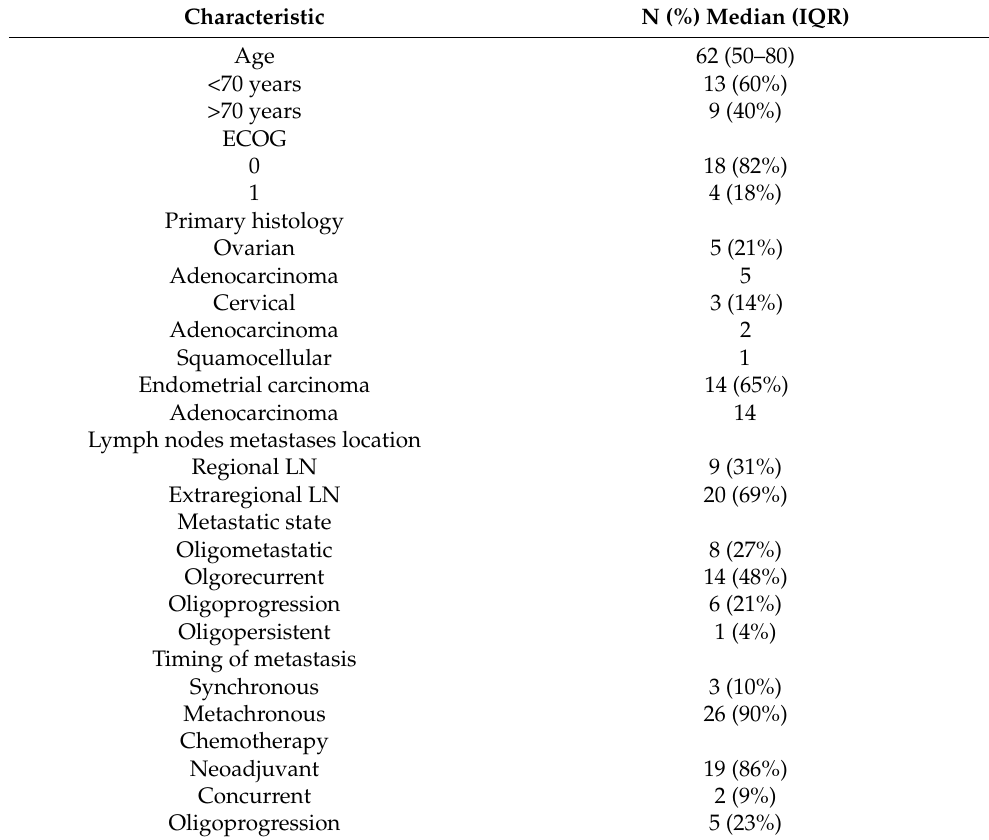
Table 1. Clinicopathological characteristics of the